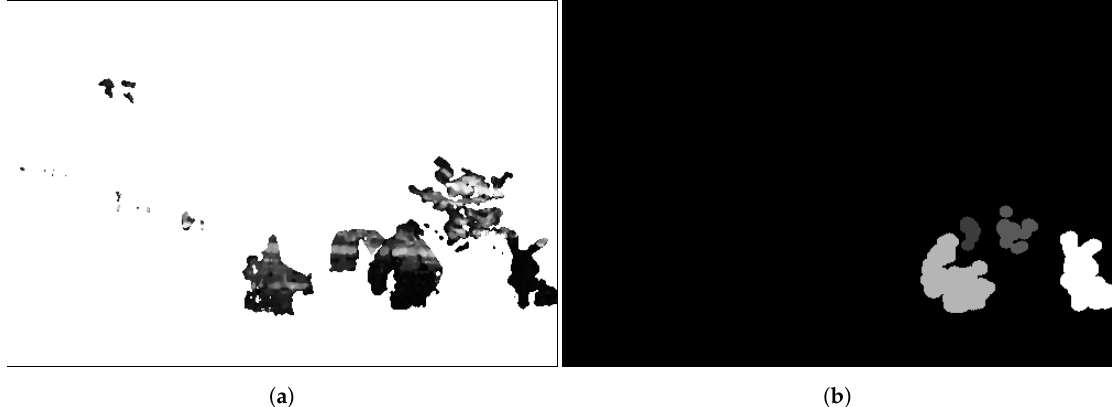
Figure 7. Segmentation in regions from point of view i . ( a ) ∆ i . ( b ) Detected change